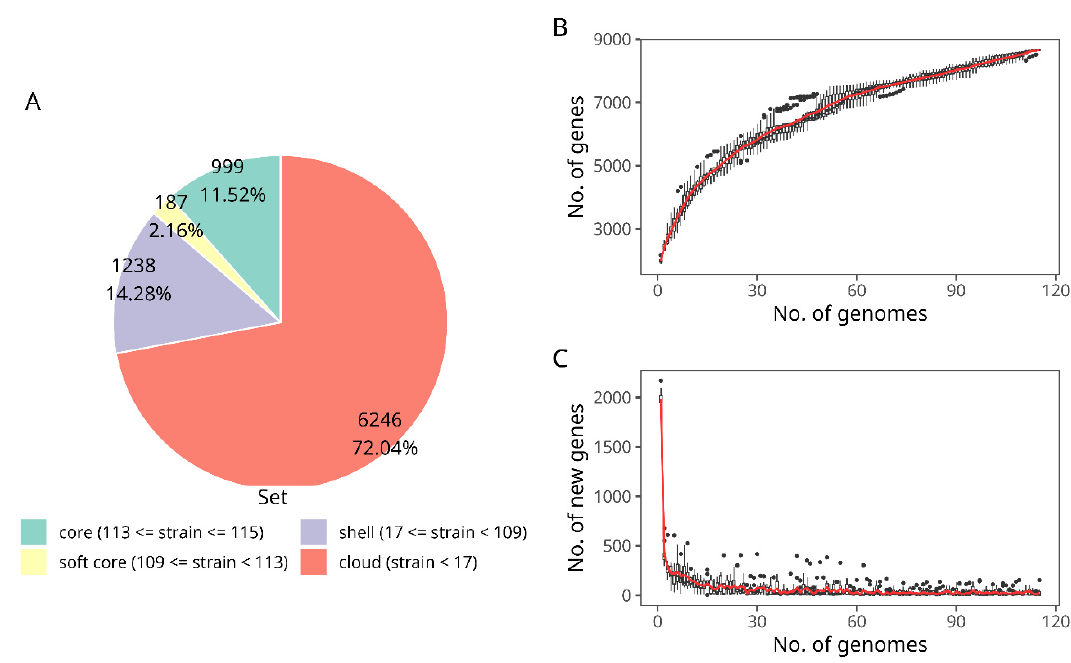
Figure 3. Pangenome of B. longum subsp. longum strains. ( A ) Pie chart indicating the gene set in the pangenome. ( B ) Plot of the accumulate number of new genes against the number of genomes added in the pangenome. ( C ) Number of genes attributed to the core genome versus the number of genomes added in the core genome